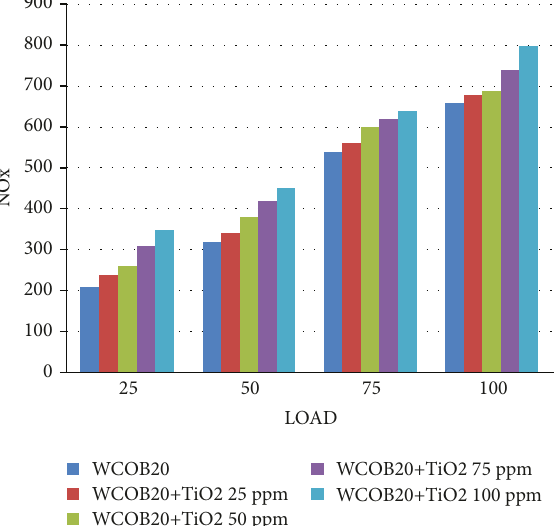
Figure 10: Variation of hydrocarbon with respect to load.